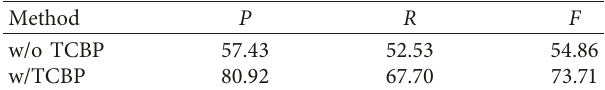
Table 5: Comparison of model performance with or without text center edge probability.